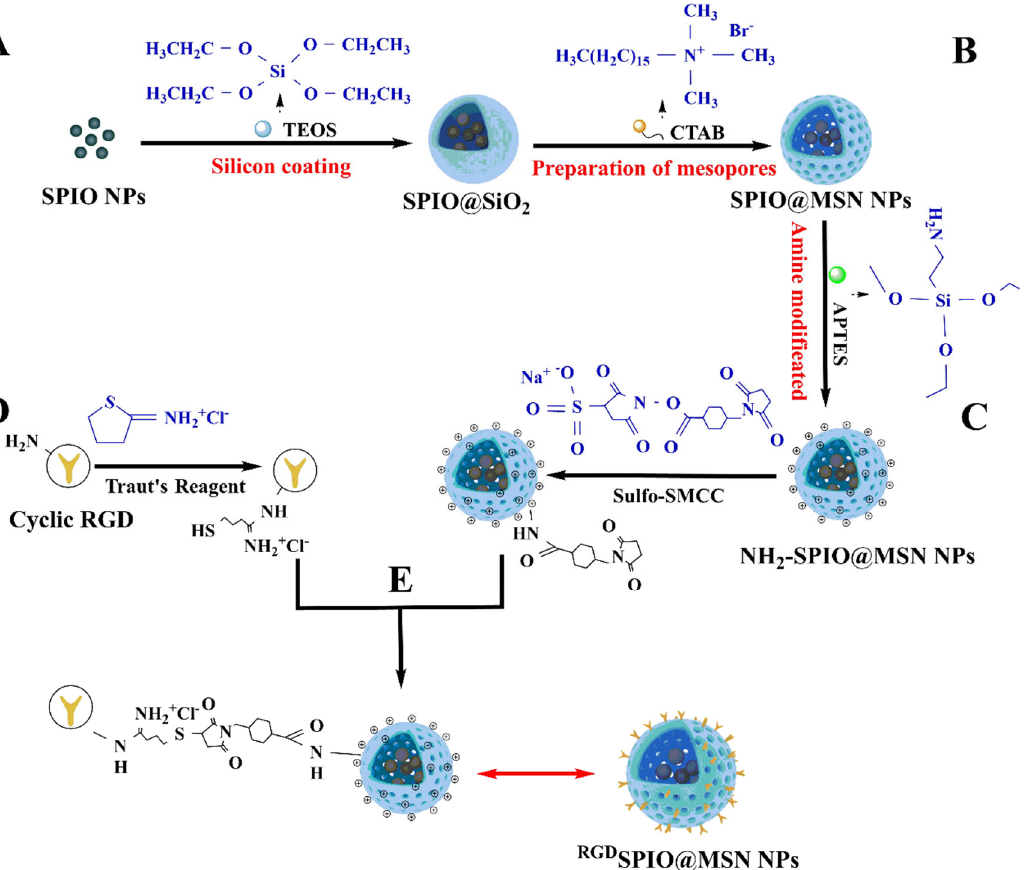
Scheme 2. Schematic diagram of the chemical formation of the cyclic RGD peptide ‐ targeted mag